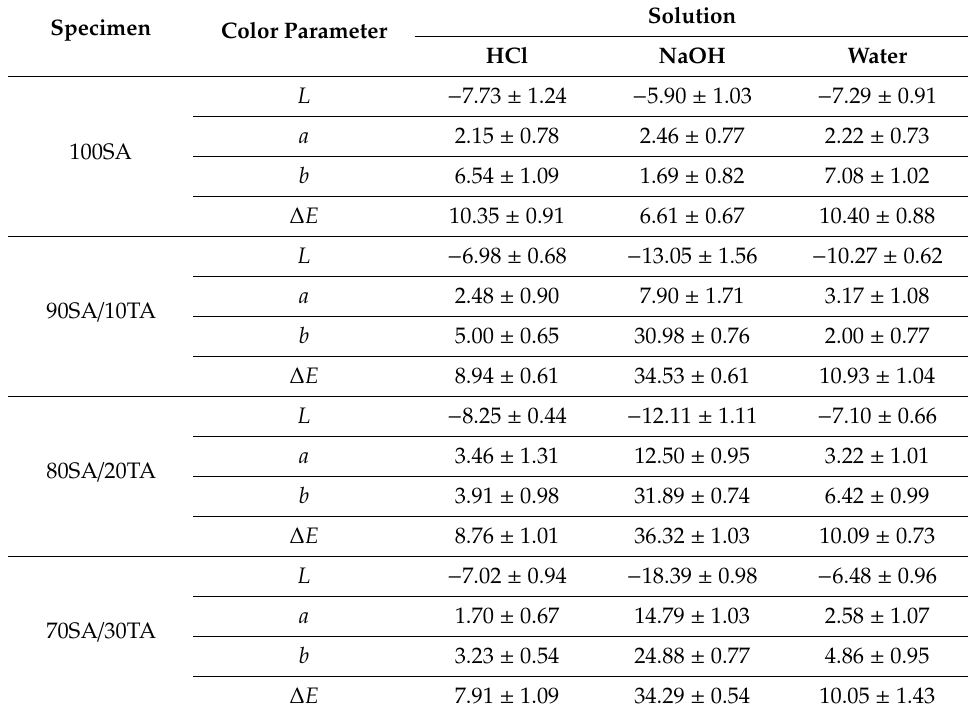
Table 2. Antioxidant activity (RSA%) of sodium alginate/tannic acid films.